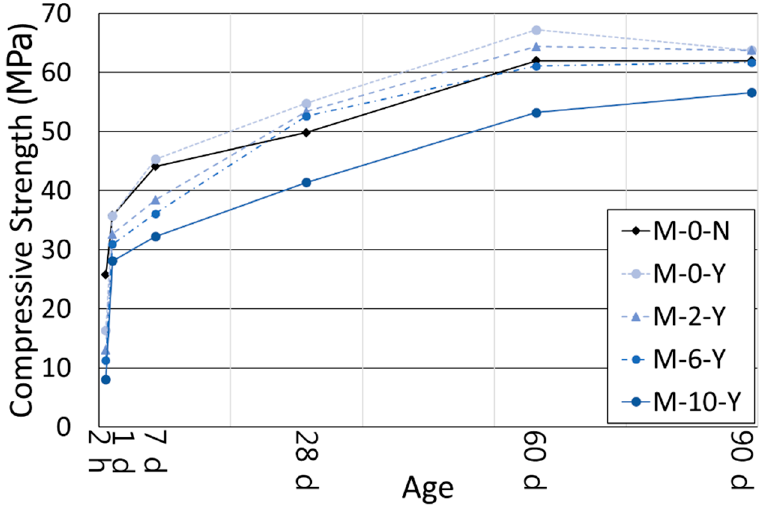
Figure 4. The compressive strengths of the mortars. Table 4. The compressive strengths of the mortars (unit: MPa).